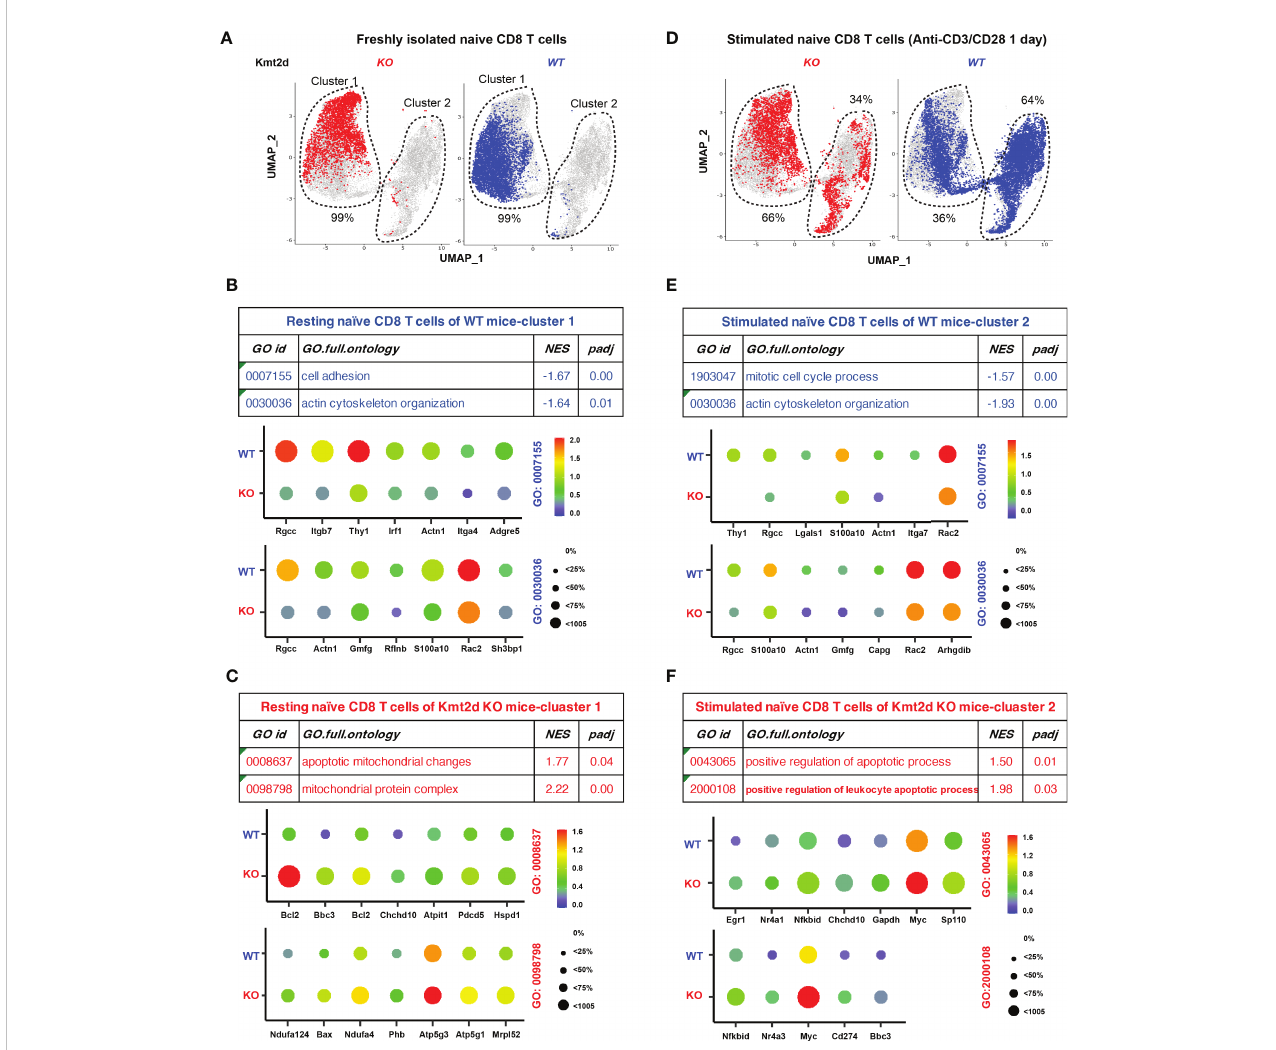
FIGURE 5 Altered expression of apoptosis related genes in single CD8 + T cells of Kmt2d KO mice. (A) UMAP of freshly isolated naive CD8 + T cells from Kmt2d WT and Kmt2d KO mice. (B) Enriched gene expression and associated GO functional groups analyzed by GSEA in freshly isolated naïve CD8 + T cells from Kmt2d WT mice. NES refers to normalized enrichment score. padj refers to adjusted p-value (FDR). (C) Enriched gene expression and associated GO functional groups analyzed by GSEA in freshly isolated naïve CD8 + T cells from Kmt2d KO mice. (D) UMAP of in vitro stimulated (antiCD3/anti-CD28 for 1 day). Percentages indicate of cells in each of two clusters. (E) Enriched gene expression and associated GO functional groups analyzed by GSEA in stimulated naïve CD8 + T cells from Kmt2d WT mice. (F) Enriched gene expression and associated GO functional groups analyzed by GSEA in stimulated naïve CD8 + T cells from Kmt2d KO